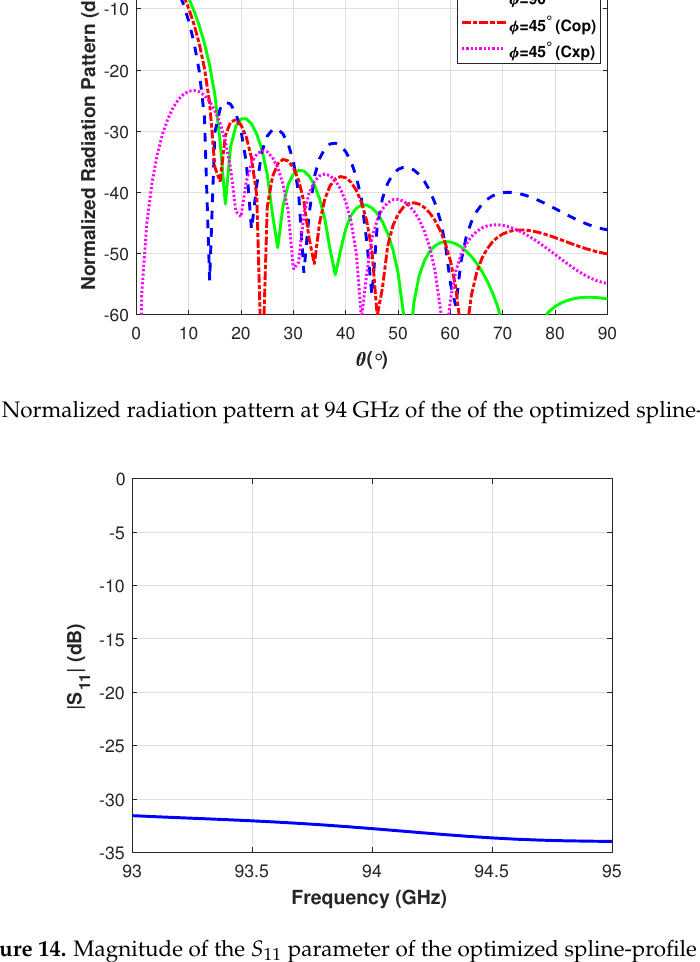
Figure 14. Magnitude of the S 11 parameter of the optimized spline-profile